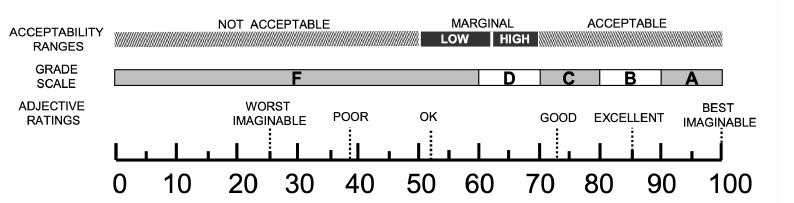
Figure 12. Adjective rating scale for the SUS score showing different regions ranging from ‘worst imaginable’ to ‘best imaginable’ [75].